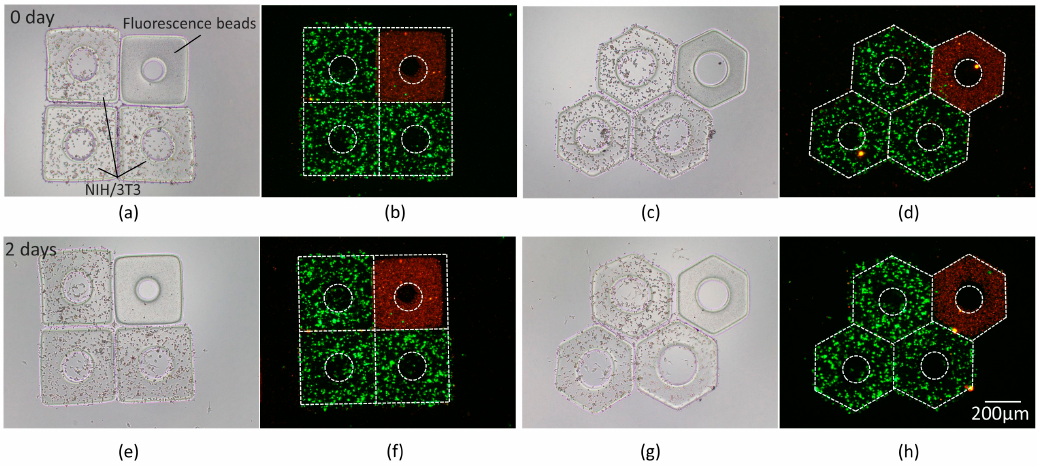
Figure 12. Images of red fluorescence beads and NIH / 3T3 cells in micromodules; ( a , c ) Bright field images. ( b , d ) Fluorescence images. ( e – h ) Images after 2-day culture. The contours of micromodules are marked by white dash lines.